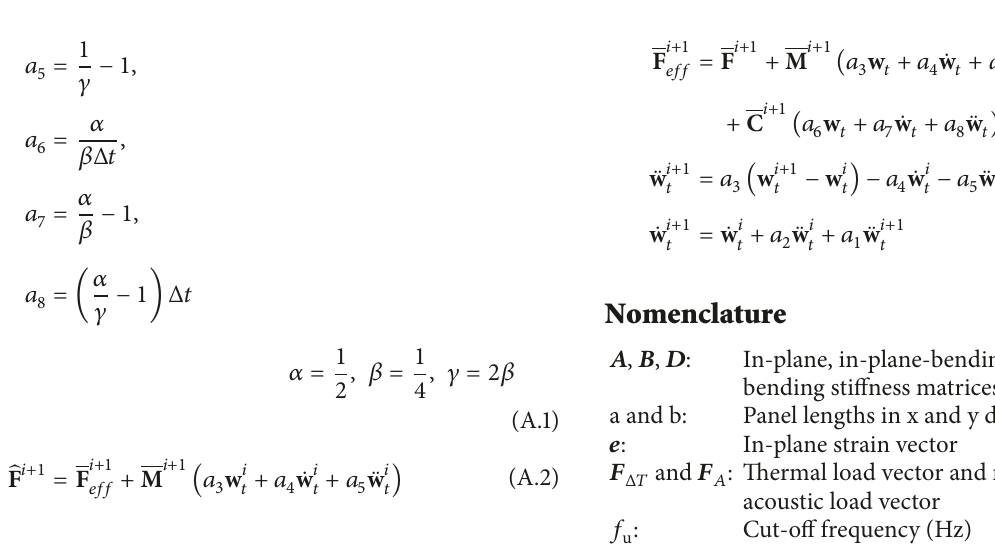
Figure 11: Random vibrations about buckled position (a/h =